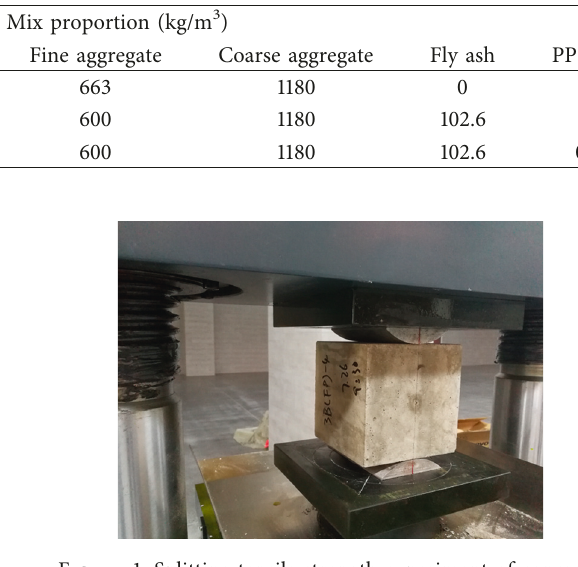
Table 1: Mix proportions of concrete composites.